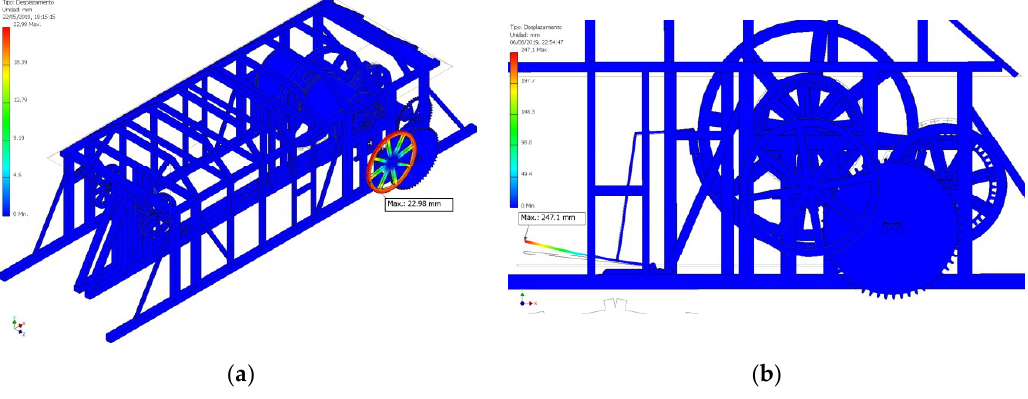
Figure 25. Location of the highest displacement: ( a ) blockage situation and ( b ) braking situation.